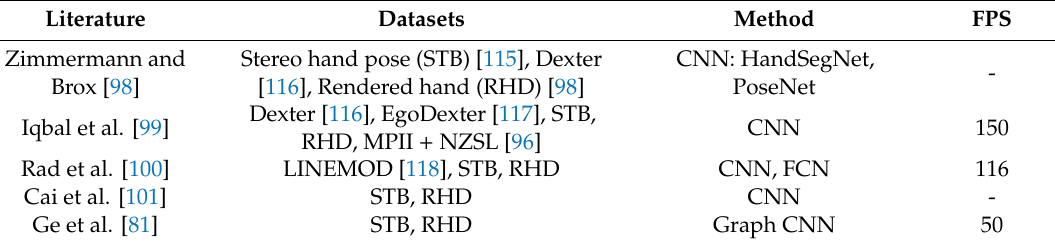
Table 5. Summary of discriminative methods for hand pose estimation with RGB